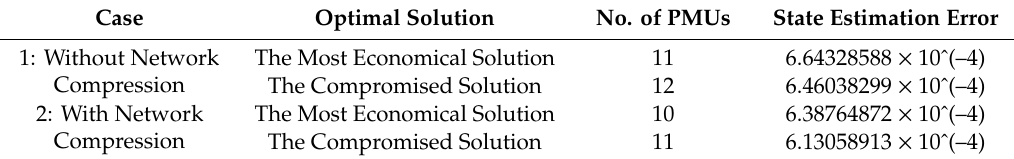
Table 1. Comparison of two cases based on network compression.